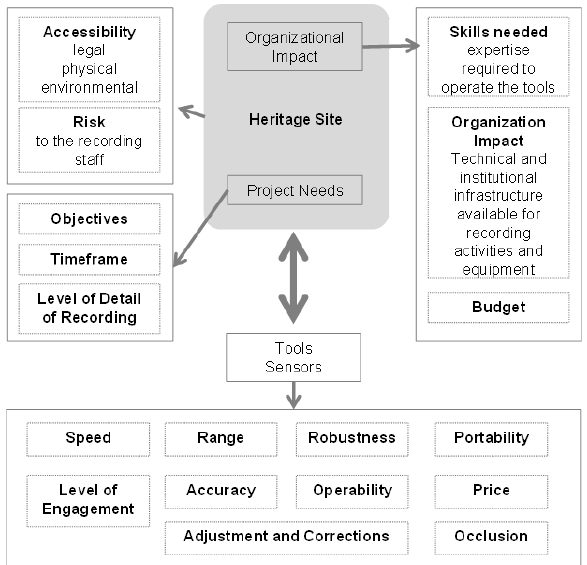
Figure 1. Variables for the selection of tools for heritage recording. Source: based on Santana et al. (2010).